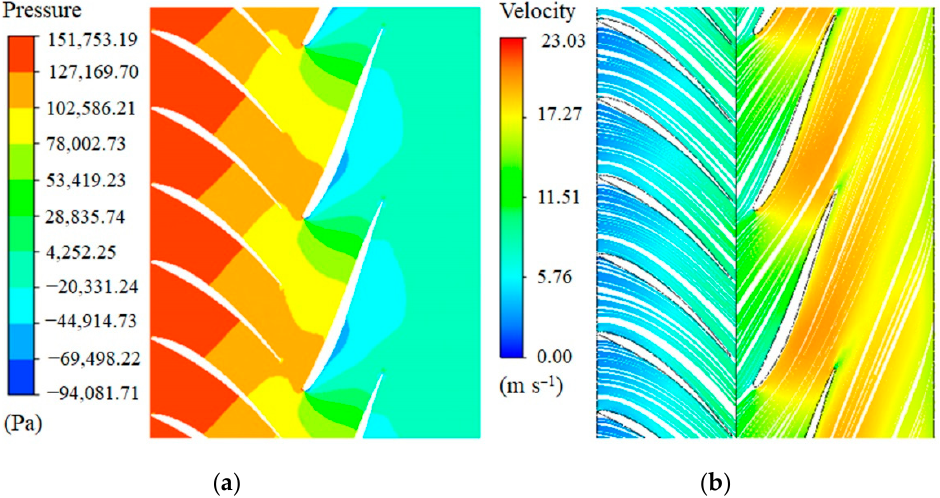
Figure 26. Pressure and streamline distribution between guide vanes and runner vanes: ( a ) pressure contour after shape change; ( b ) streamline contour after shape change.